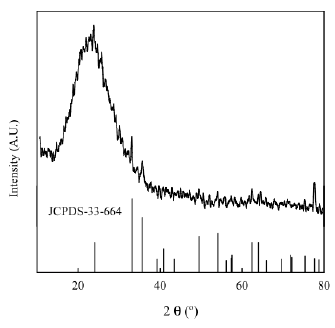
Figure 1. TEM micrograph of FeNP@SBA-15 material.